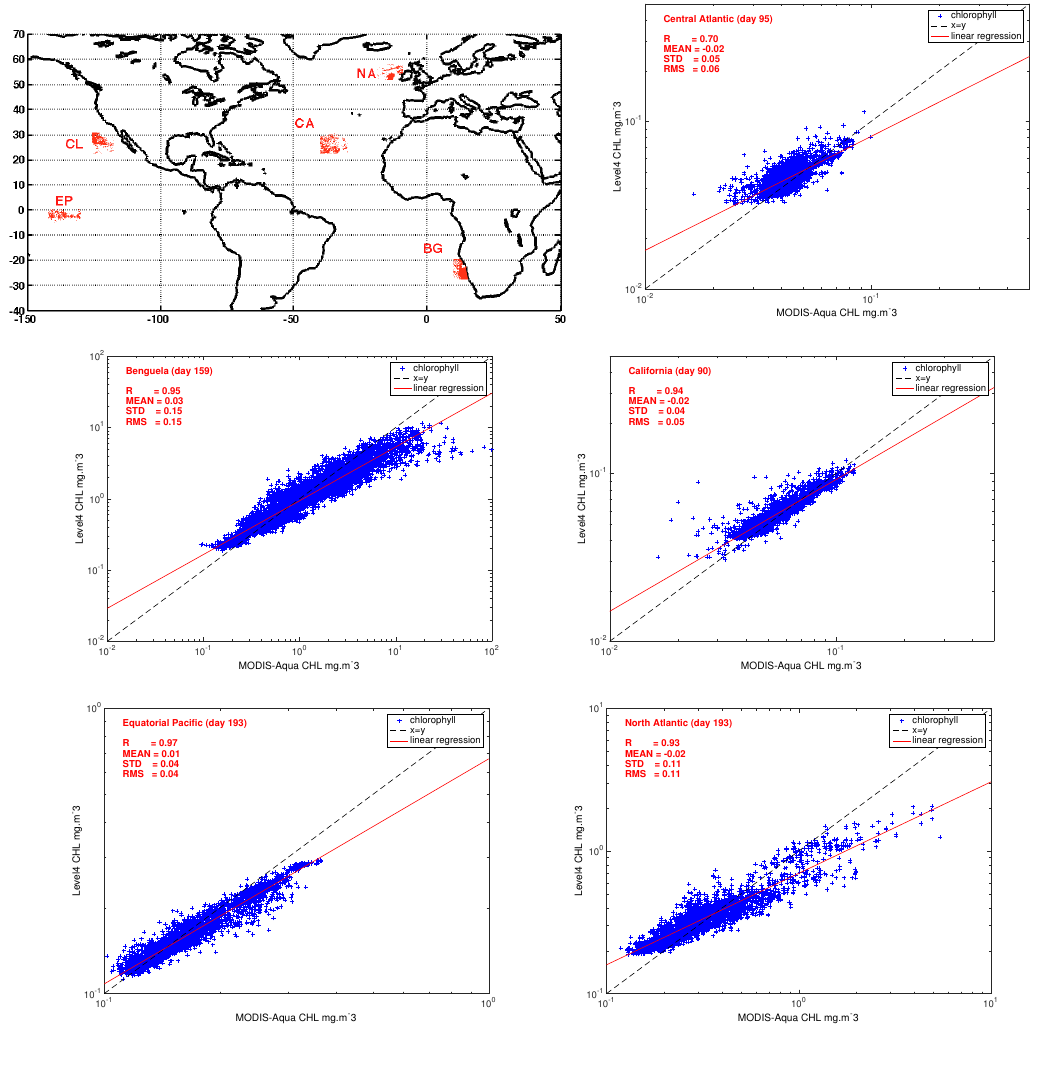
Figure 4. Artificial clouds generated for validation purposes in the Central Atlantic (CA), Benguela upwelling (BG), California Pacific (CL), Equatorial Pacific (EP) and North Atlantic (NA) ( top left panel ). Validation of reconstruction under artificial clouds for MODIS Chl- a concentration. For CA region day 95, BG region day 159, CL day 90, EP day 193, and NA day 193 of year